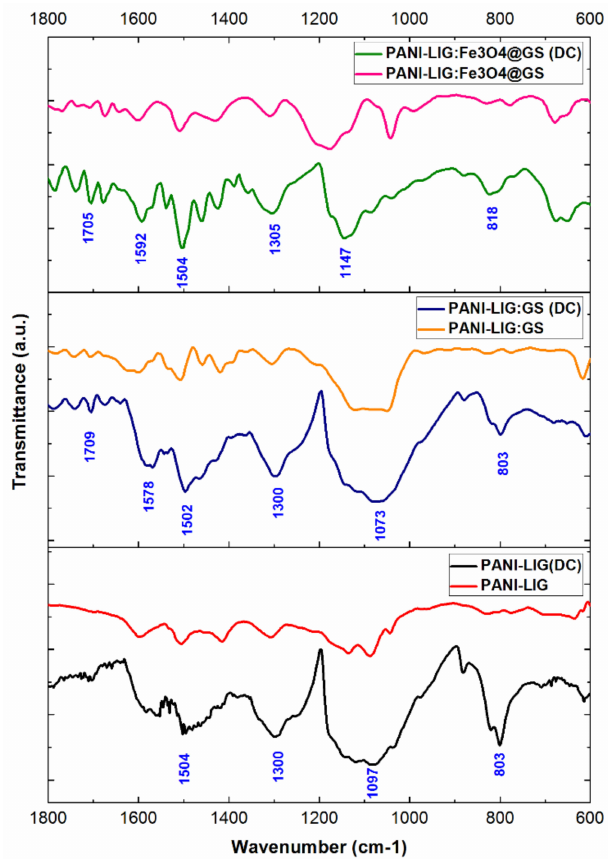
Figure 2. Fourier transform infrared spectroscopy (FTIR) spectra of PANI-LIG-based